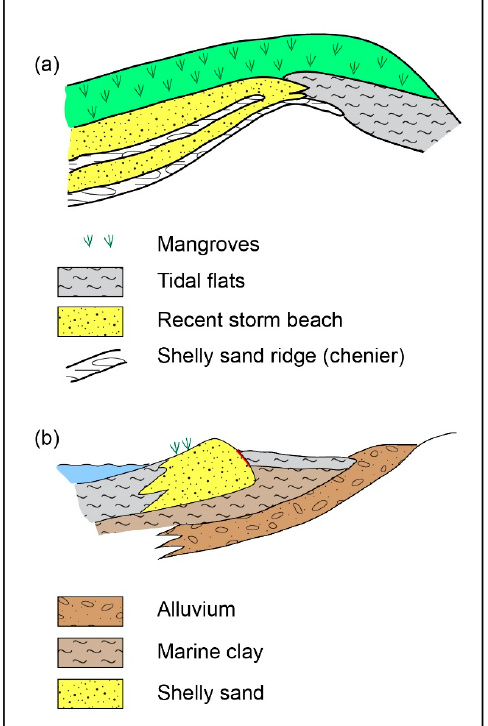
Figure 11. Chenier ridges in tropical northern Australia. ( a ) Transect across a chenier plain. (Adapted and greatly simplified from [104] Figure 1 and [105] Figure 6). ( b ) Generalised stratigraphy of a mangrove coast in the late Holocene, following the postglacial rise of the sea level to its present elevation at this hypothetical site some 6000 years ago. (Adapted and simplified from [105] Figure